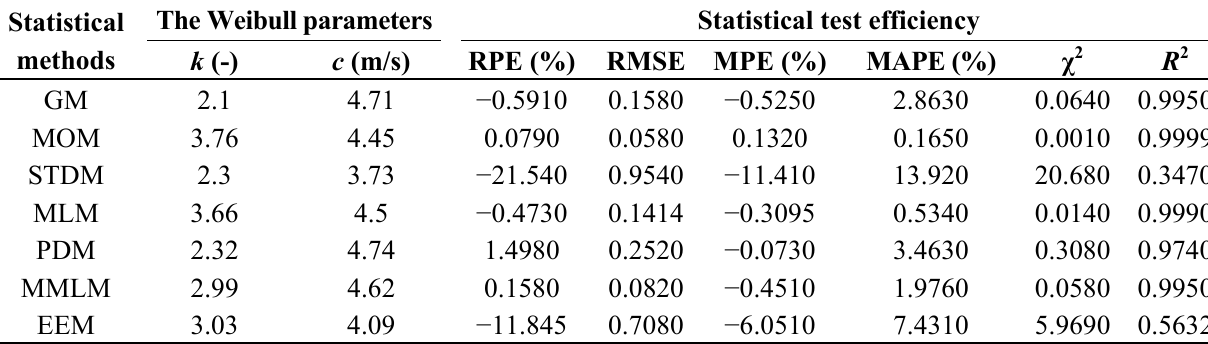
Table 9. The Weibull distribution analysis for Station-III at 30m